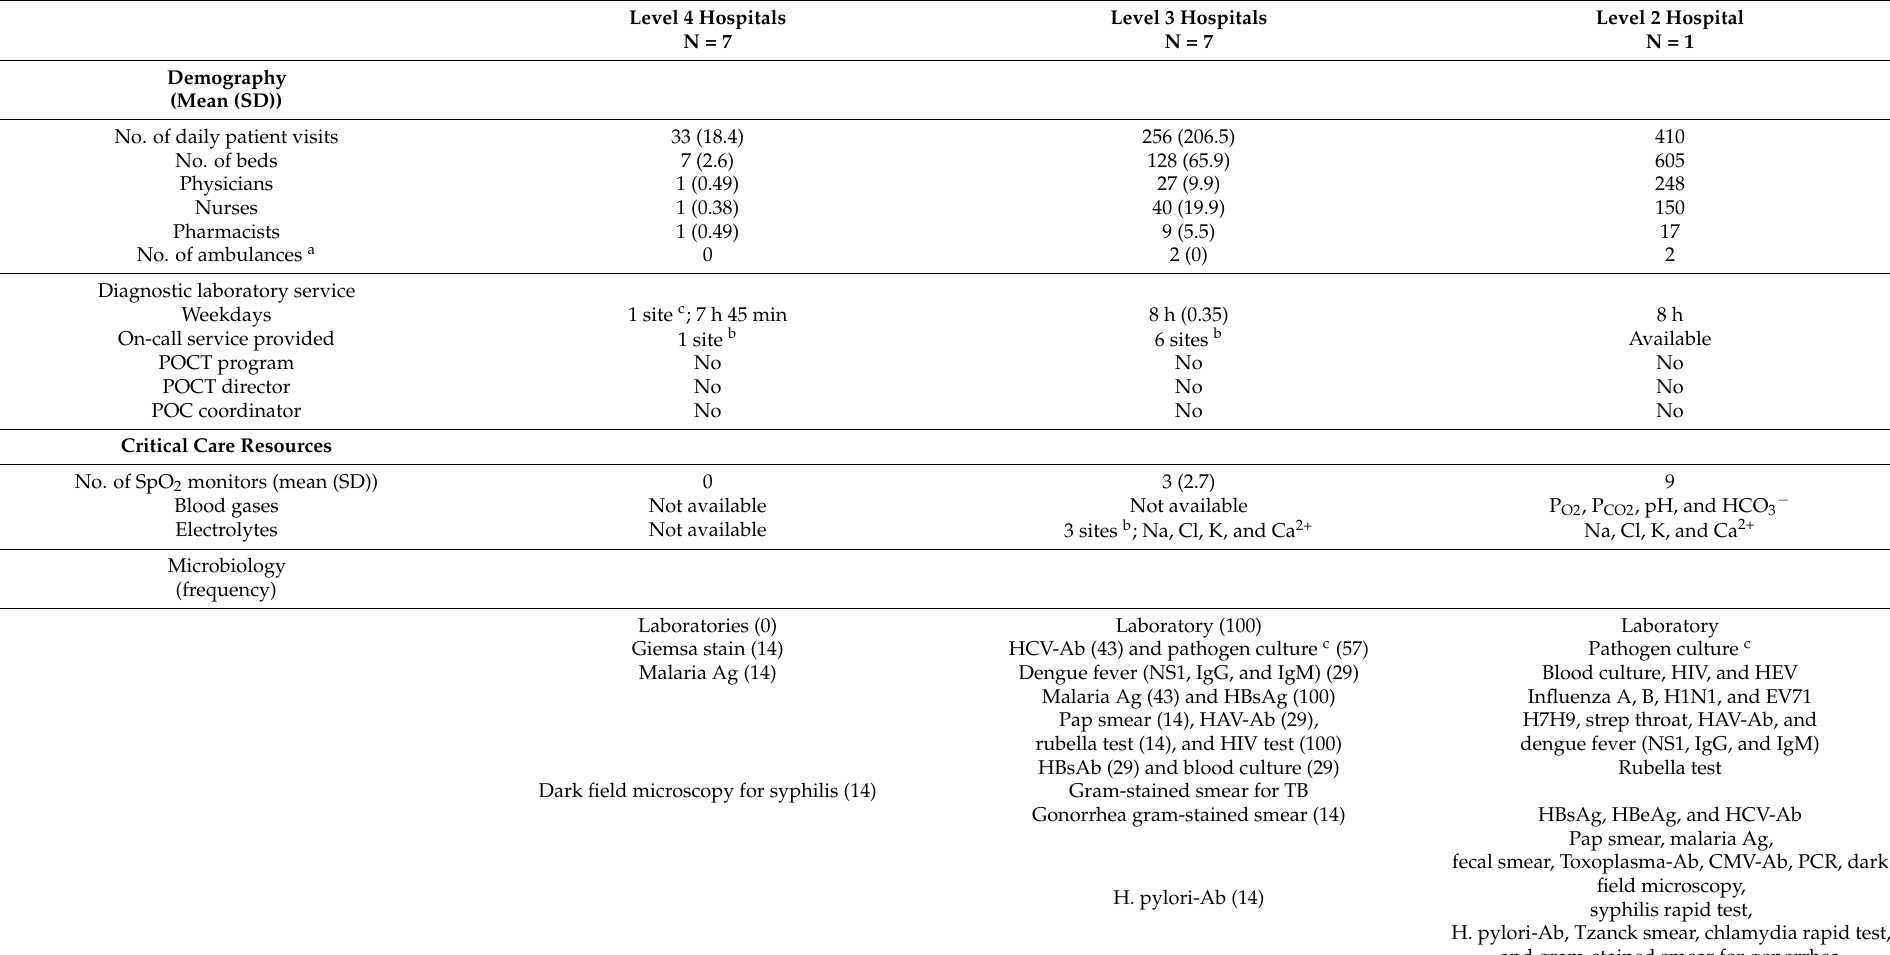
Table 1. Demography, critical care resources, and point-of-care testing utilization in Level 4 (7), Level 3 (7), and Level 2 (1) hospitals in Central